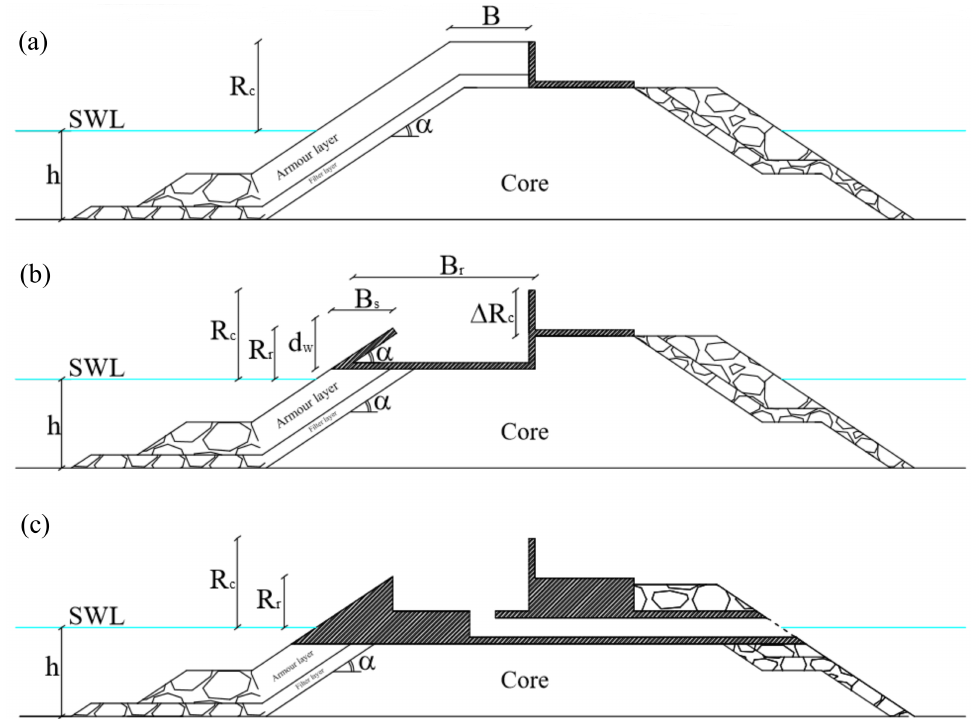
Figure 2. ( a ) The traditional rubble mound breakwater, ( b ) the OBREC physical model, and ( c ) the OBREC numerical model (adapted from Vicinanza 2014 [26], with permission from ELSEVIER, 2018). The main geometric parameters are: B r the reservoir width, B s the horizontal extension of the sloping plate, α its inclination, d w the height of the sloping plate and R r and R c the freeboard crests of the sloping plate and of the rear wall,